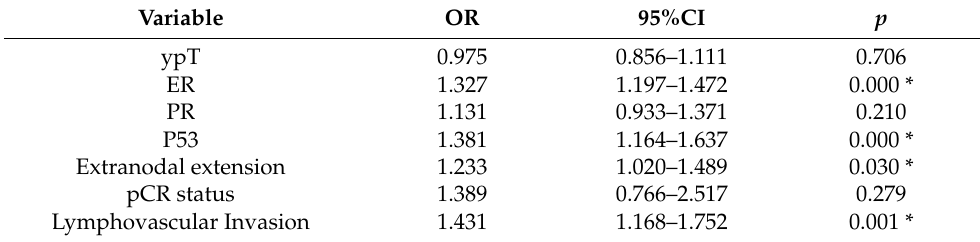
Table 6. Binary logistic regression analysis of HER2